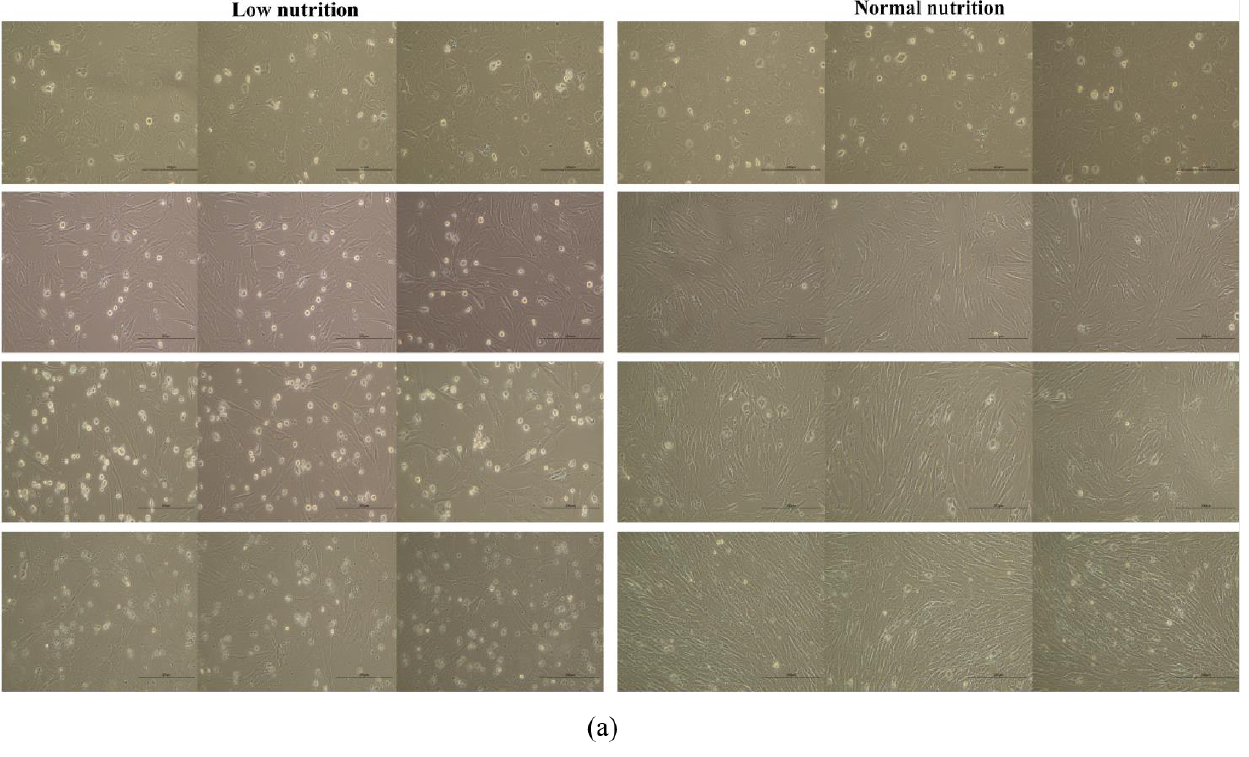
Figure 7. CDK2 knockdown expression affects the cell cycle of sheep primary embryonic myoblasts.